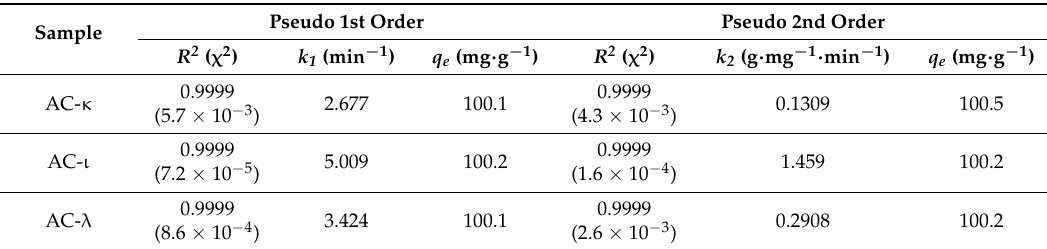
Figure 10. Time profile of CIP adsorption capacity over 30 min and the corresponding kinetic model fitting using pseudo 1st and pseudo 2nd order equations. Table 4. Kinetic parameters estimated from pseudo 1st order and pseudo 2nd order models and the evaluation of its fittings for an initial CIP concentration of 50